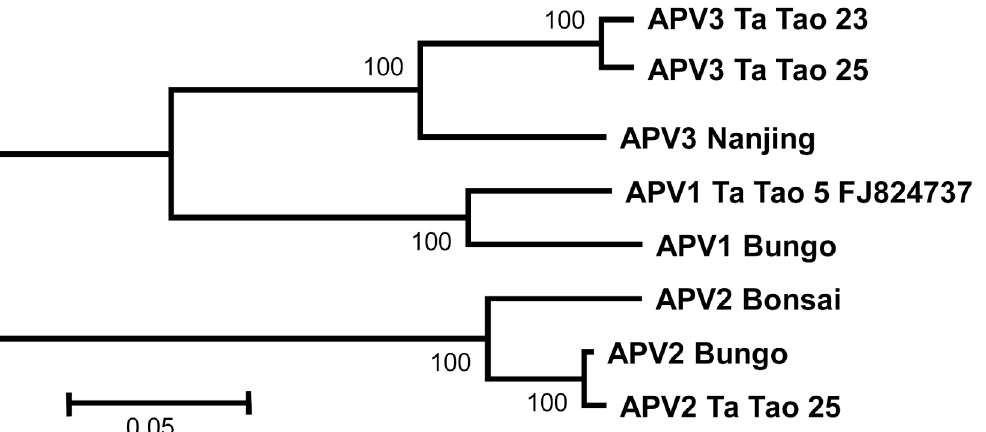
Fig 4. Unrooted phylogenetic tree reconstructed using the amino acid sequences from the coat protein of Asian prunus virus 1, 2, and 3 isolates. Tree was constructed by the neighbor-joining method and the statistical significance of branches was evaluated by bootstrap analysis (1,000 replicates). Only bootstrap values above 70% are indicated. The scale bar represents 5% amino acid divergence.